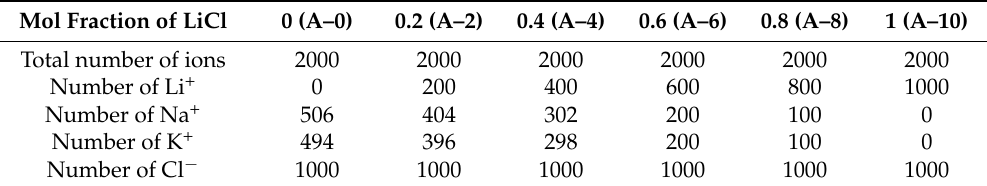
Table 2. Systems of different